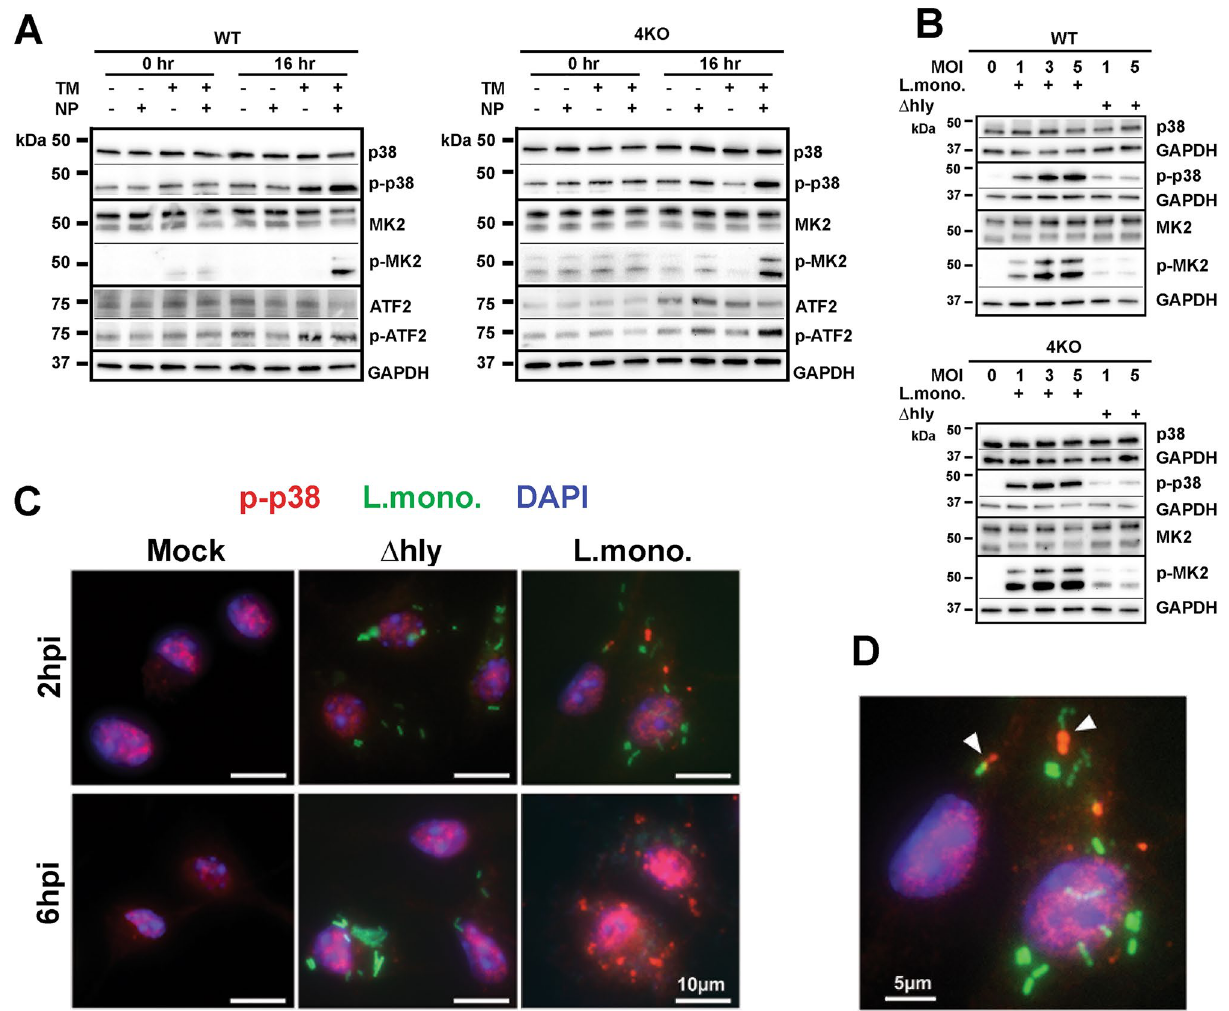
Figure 4. p38MAPK is activated in Mϕs after their exposure to L.monocytogenes or synthetic nanoparticles. (A) Western blot analysis of activation of p38 and its downstream signaling targets MK2 and ATF2 at indicated time points in WT and 4KO BMDMs after their treatment with DMSO (-), TM, NP, or TM and NP combination. N = 3. (B) Western blot analysis of activation of p38 and its downstream signaling target MK2 in WT and 4KO BMDMs after infection with wild-type L. monocytogenes (L. mono) or its isogenic strain (Δ hly ) at 6 h post infection. N = 2. (C) Immunofluorescent staining of WT BMDM infected with CFDA-labeled (green) wild- type L. monocytogenes (L. mono) or its isogenic strain (Δ hly ) at 2 h and 6 h post infection. Cells were stained for phosphorylated p38MAPK (p-p38) –specific antibody (red) and DAPI staining to show cell nuclei (blue). N = 3. (D) Enlarged cropped image from 2-h panel ( C ) for L.monocytogenes . Arrows point to phosphorylated p38MAPK staining (red) in proximity to the wild-type L. monocytogenes cells